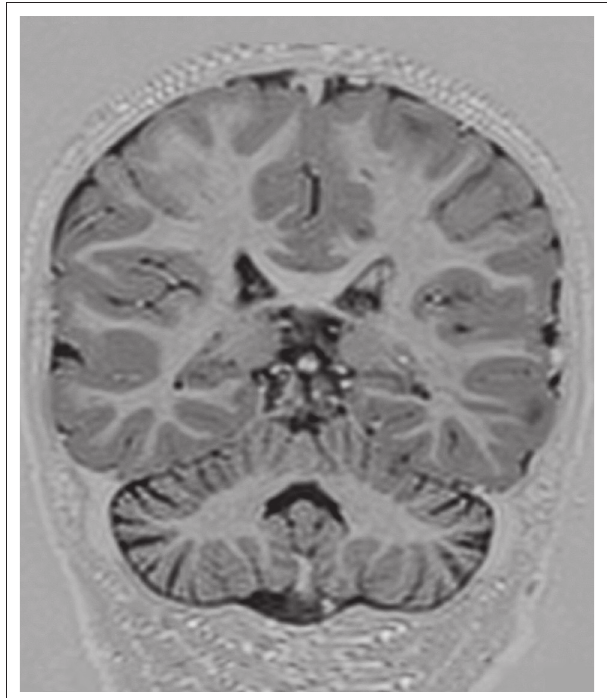
FIGURE 3: Coronal FLAIR MR image. FIGURE 4: Coronal T1-Inversion Recovery MR image.